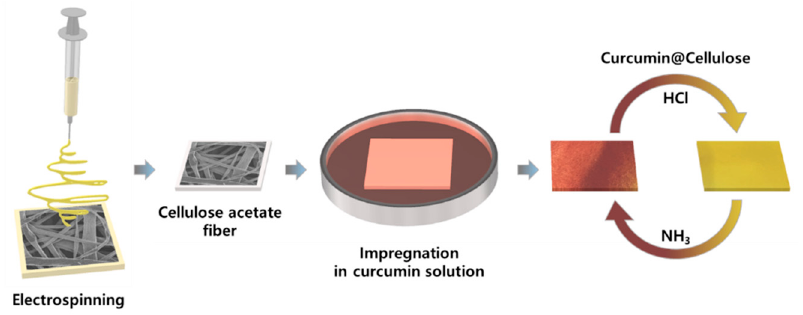
Figure 1. Schematic illustration showing the fabrication process of fabric samples dyed with curcumin from cellulose acetate and its chromatic responsive behavior upon the exposure to hydrogen chloride and ammonia